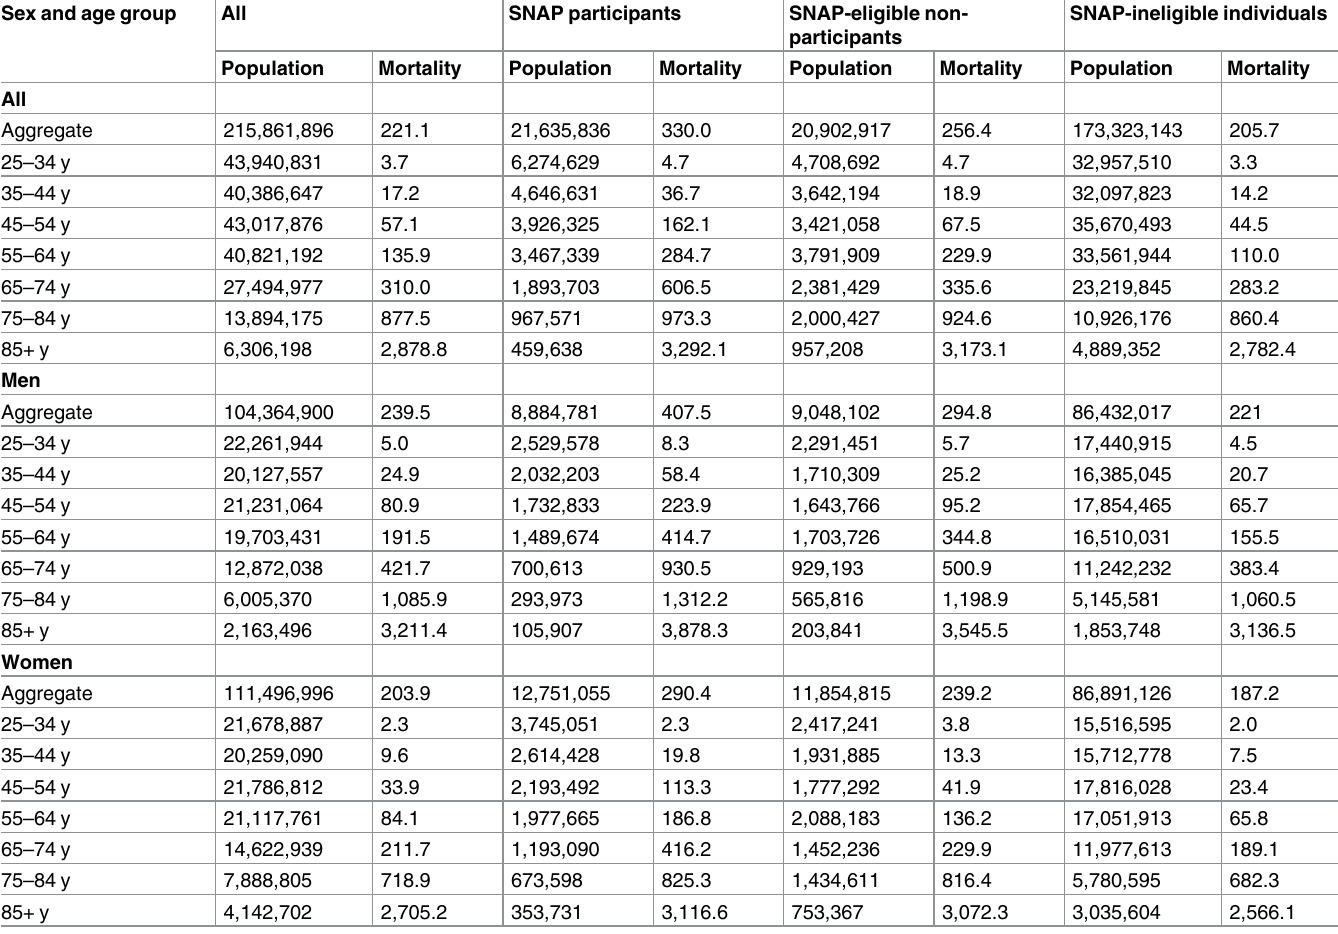
Table 1. Population and cardiovascular disease mortality per 100,000population by SNAP status, stratified by sex and